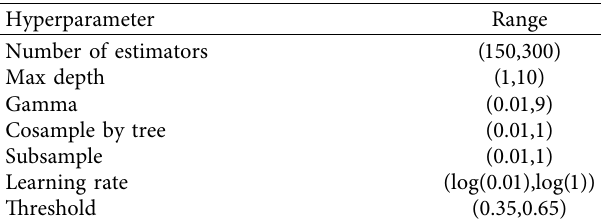
Table 9: Range and numbers of hyperparameters For Light